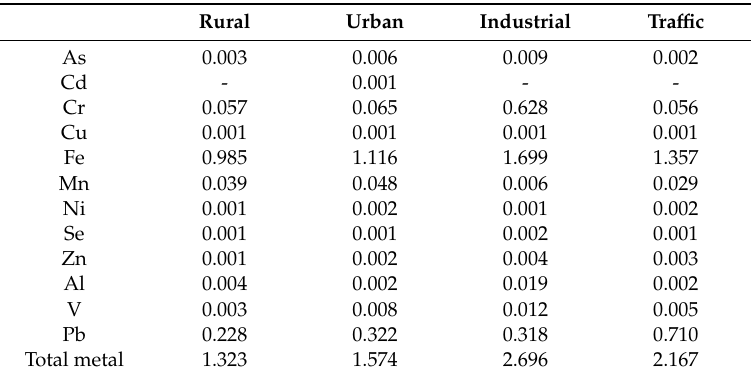
Table 4. Concentration of metals (ng / m 3 of air) in PM 2.5